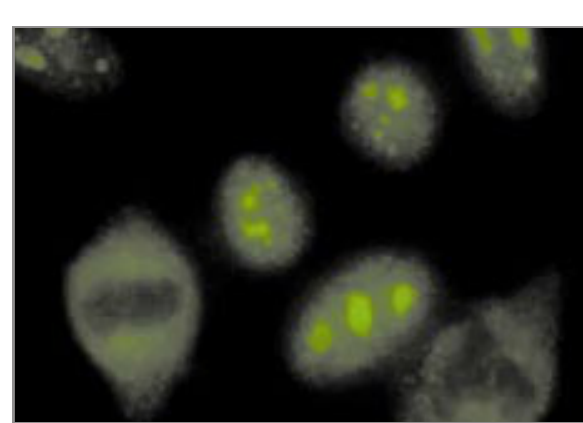
Figura 7 – Nuclear pontilhado fino